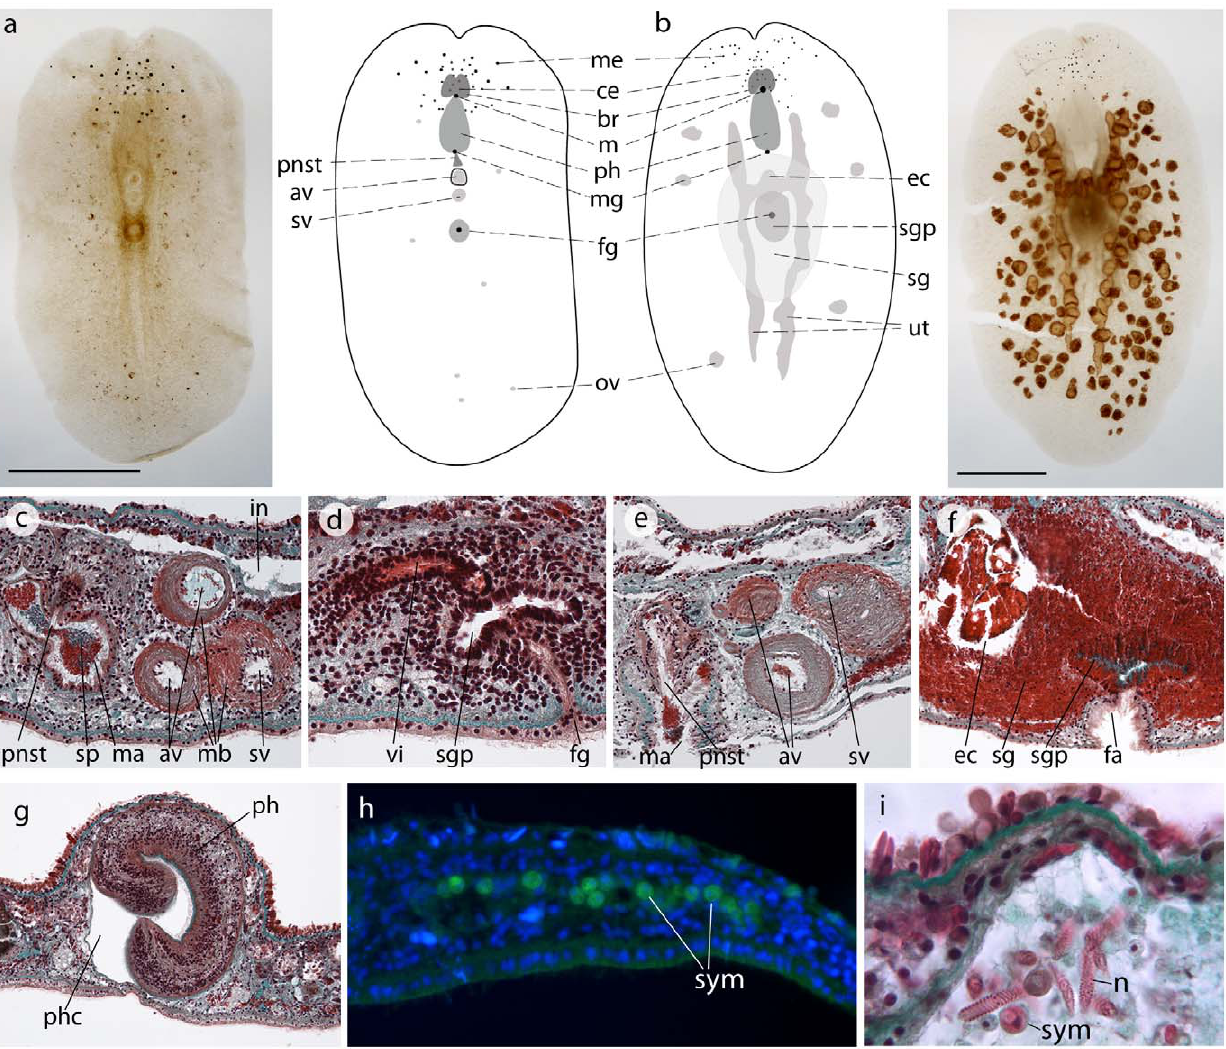
Figure 2. Anatomy and morphology of Amakusaplana acroporae from Lizard Island, Australia. Wholemounts and schematic representations of (a) a 3.2 mm and (b) a 5.0 mm long A. acroporae (scale =1 mm) showing gross morphology and development of the female reproductive structures. Individuals , 4 mm in length possess (c) a mature male reproductive system, but (d) an immature female system. Individuals . 4 mm in length possess mature (e) male and (f) female reproductive systems. (g) A cross section through the distal portion of the pharynx reveals its cleft morphology. Symbiodinium are present in the gut and parenchyma of A. acroporae , and may be observed (h) by autofluorescence and (i) light microscopy, spirocysts are also visible in the gut lumen. av accessory vesicle, br brain, ce cerebral eye, ec egg chamber, fa female atrium, fg female gonopore, in intestine, m mouth, ma male atrium, mb muscle bulb, me marginal eye, mg male gonopore, ov ovary, ph pharynx, phc pharyngeal cavity, pnst penis stylet, sc spirocysts, sg shell glands, sgp shell gland pouch, sp sperm, sv seminal vesicle, sym Symbiodinium , ut uteri, vi vagina interna